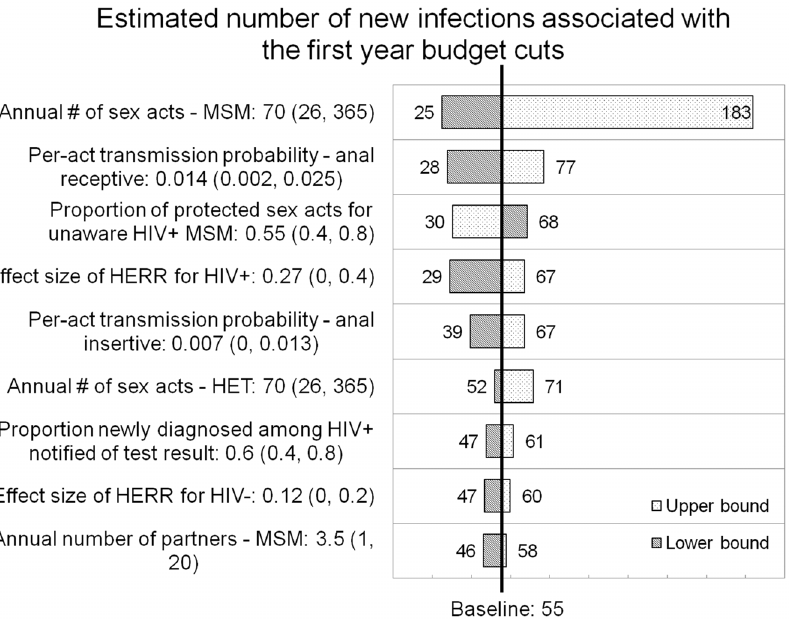
Figure 1. One-way sensitivity analysis. We plotted the input parameters whose change to either the lower or the upper bound resulted in a change of 10% or more in the additional number of new infections associated with the first year of budget cuts. The shadow bar corresponds to the lower bound and the dotted bar corresponds to the upper bound value associated with a particular parameter. For example, if the annual number of sex acts for MSM was 365, the expected number of new infections associated with the first year of the budget cut would increase 236% to 183, from the baseline estimate of 55. If the annual number of sex acts for MSMs was 26, the expected number of new infections associated with the first year budget cuts would decrease by 55% to 25, from the baseline estimate.